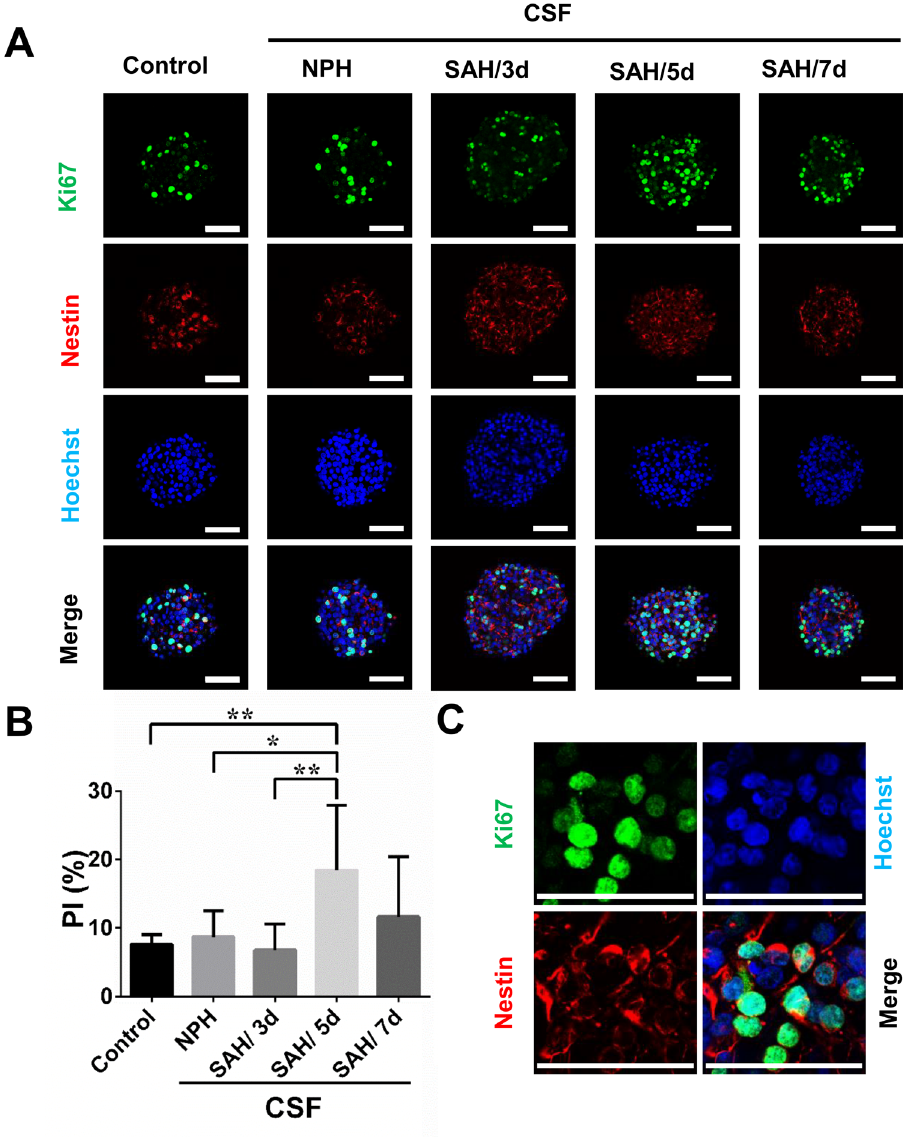
Figure 2. The effects of CSF samples collected at different post-SAH times on NSC proliferation. ( A ) The cultured NSCs without treatment (control) or treated with CSF samples collected from patients with NPH or SAH on day 3, 5, or 7 after onset were double immunostained with anti-Ki-67 (green) and anti-nestin (red) antibodies with Hoechst 33258 (blue) staining. Scale bar = 50 μ m. ( B ) Comparison of the PI between different groups is shown. N = 6 for each group. ( C ) A high magnification image shows most Hoechst positive cells with or without Ki-67 immunoreactivity are also immunoreactive to nestin. Scale bar = 50 μ m. * p < 0.05; ** p < High proliferation index in treatment with CSF collected from SAH patients. The demographic data and clinical features of 36 SAH patients (age, 62 ± 13 years) are summarized in Supplementary Table S1. The SAH was caused by aneurysm rupture in all patients (two with dissecting aneurysm). Twenty patients (56%) had aneurysm located at anterior circulation and 16 (44%) at posterior circulation. The mean initial Glasgow Coma Scale (GCS) score was 11 ± 4 and the mean SAH volume was 19 ± 14 mL. Intraventricular hemorrhage (IVH) developed in 23 of 36 patients (63.9%) and vasospasm occurred in 21 patients (58.3%). All of the patients received aneurysmal clipping (n = 33) or endovascular embolization (n = 3) within 1 day after SAH onset except for 4 patients (2, 3, 4, and 6 days after onset without rebleeding before clipping or embolization). The median modified Rankin Scale (mRS) score accessed at post-SAH 3 months was 3 (0–6). The NSCs treated with CSF samples collected from 36 SAH patients on day 5 post-SAH showed a higher PI as compared to those treated with CSF samples obtained from six NPH patients and those without treatment (20.3 ± 8.8 vs . 8.2 ± 5.1 and 7.8 ± 3.0, P < 0.001) (Fig. 3A and B). The PI was then correlated with clinical informa- tion such as patient age, initial SAH volume, initial GCS, the existence of IVH, the presence of post-SAH vasos- pasm, and the location of aneurysm (Fig. 1). The PI values were positively correlated with SAH volume (Pearson’s